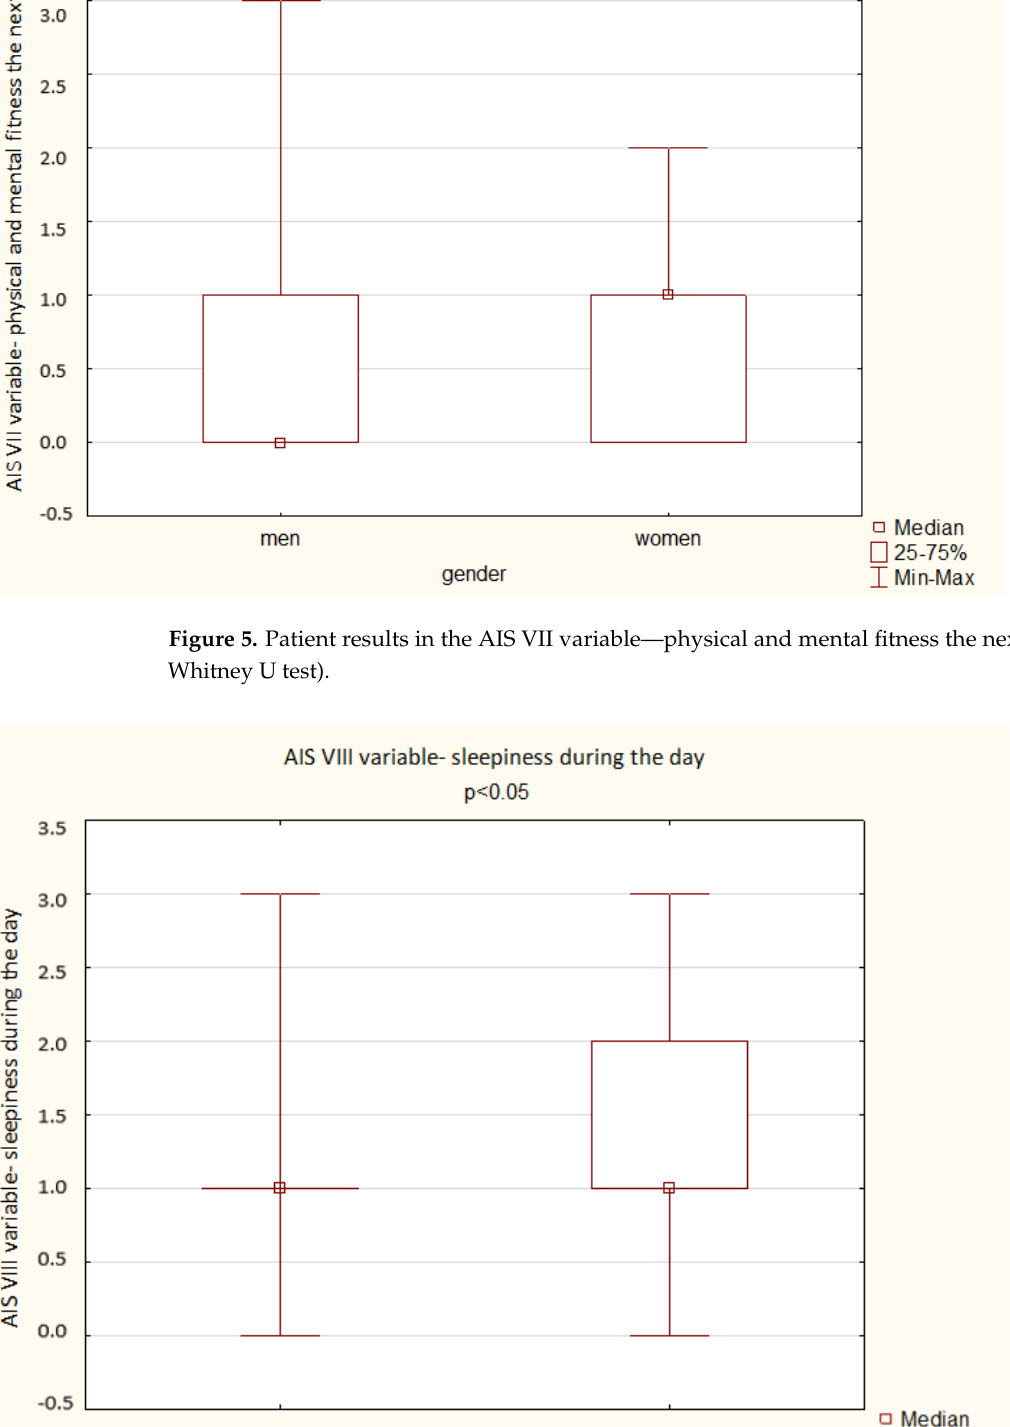
Figure 6. Patient results in the AIS VIII variable — sleepiness during the day (Mann – Whitney U test).